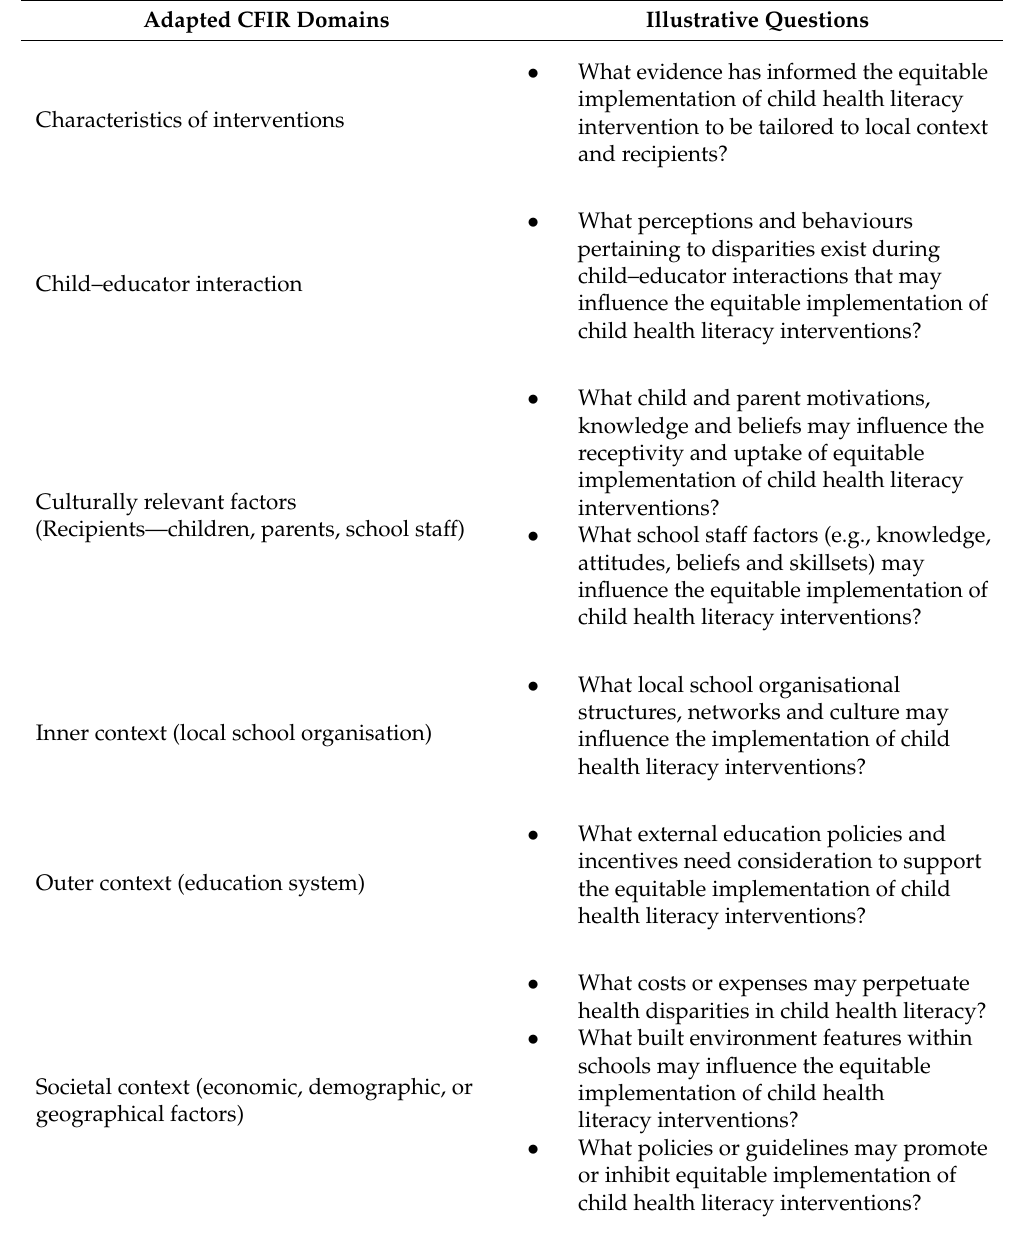
Table 2. Health Equity Adapted Implementation Framework for Child Health Literacy